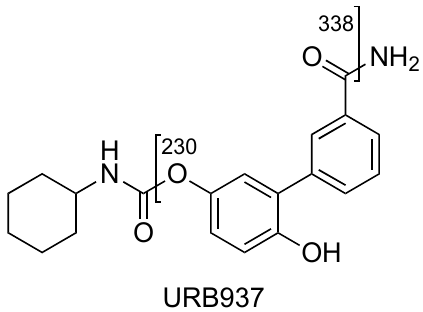
Figure 8 . Representation of the collisional-induced fragment ions of URB937 compound. Other main characteristic fragments are observed at m / z 213 due to the loss of cyclo- hexyl isocyanate and ammonia, and m / z 338 due to the loss of ammonia only (Figures 8 and 9). Figure 9 . Product ion scan of URB937 compound obtained by QqQ. Exponential scale to base 10. The ion at m / z 187, due to the loss of the carbamoyl group, is observed only at higher collision energies (figure not shown). In the case of URB937, the presence of [M 2 + Na] and